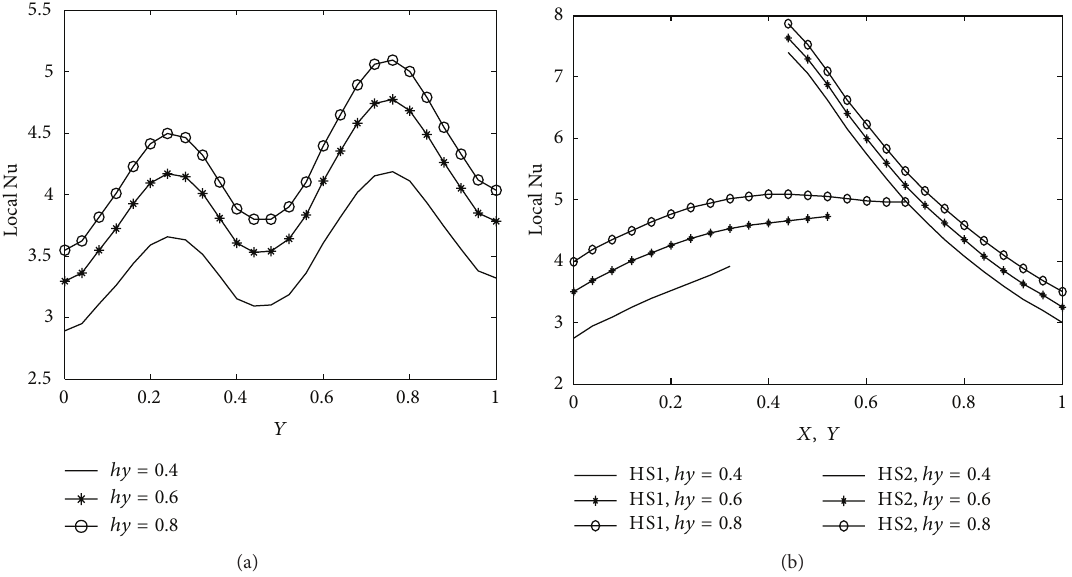
Figure 12: Variation of local nusselt number with heater length in vertical direction ℎ𝑦 at Ra = 10 5 , Pr = 0.7 , 𝐴 = 0.2 , 𝑛 = 2 , and ℎ𝑥 = 0.6 (a) along cold wavy surface and (b) along the heaters.